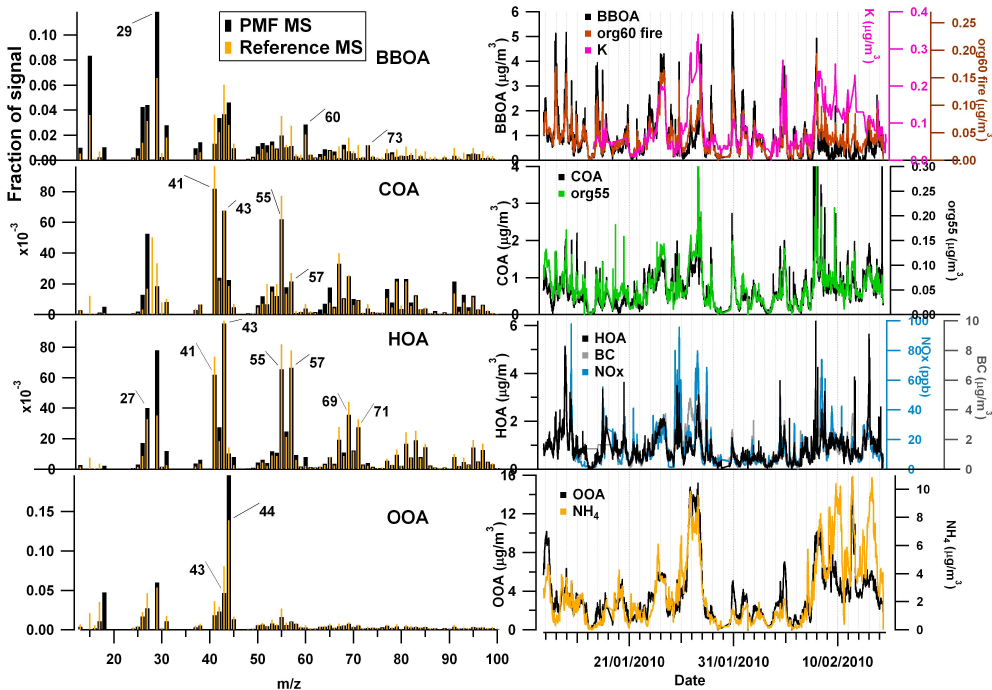
Fig. 3. PMF results: time series and mass spectral comparisons (SIRTA site). The COA reference spectrum is calculated as the mean of all cooking emissions spectra measured by He et al. (2010); other reference spectra are provided by Ng et al. (2010).